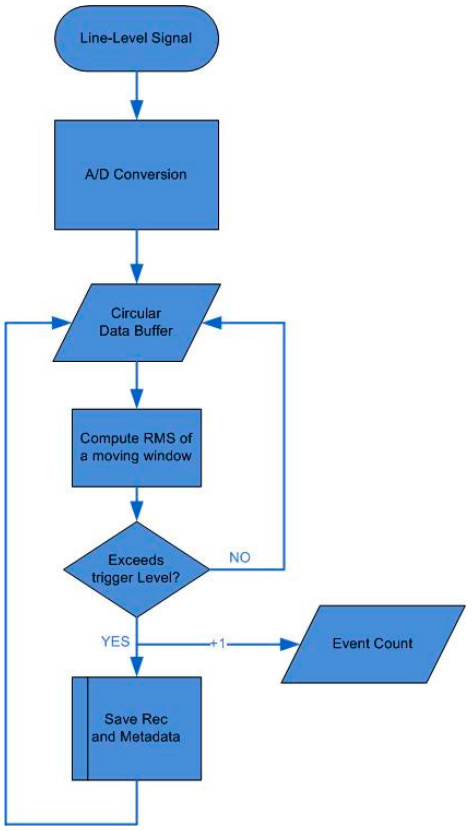
Figure 5. A diagram explaining the recording procedure. The signal is continuously stored in a cyclic buffer and the RMS value of a window of 128 samples is monitored. Once the RMS value exceeds a threshold, it triggers a recording session. A total of 20% of the samples are taken prior to the triggering point from the buffer and 80% after this event to ensure that the wingbeat onset is not missed. Metadata is composed of a timestamp, humidity, and temperature stamps that are passed to the filename.